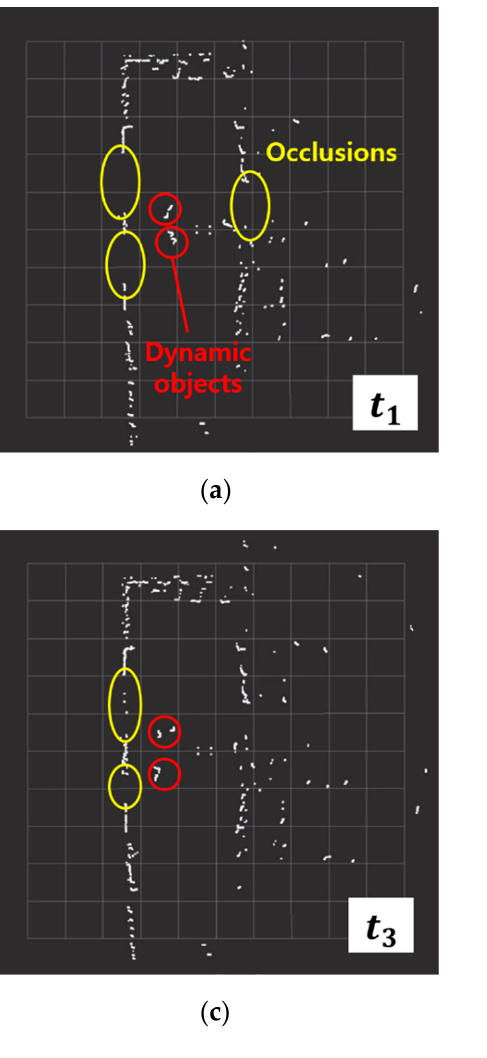
( c ) Figure 6. The generation of training images. ( a ) Raw scan range data in polar form; ( b ) ICP scan matching; ( c ) plotting of matched scans in Cartesian form.